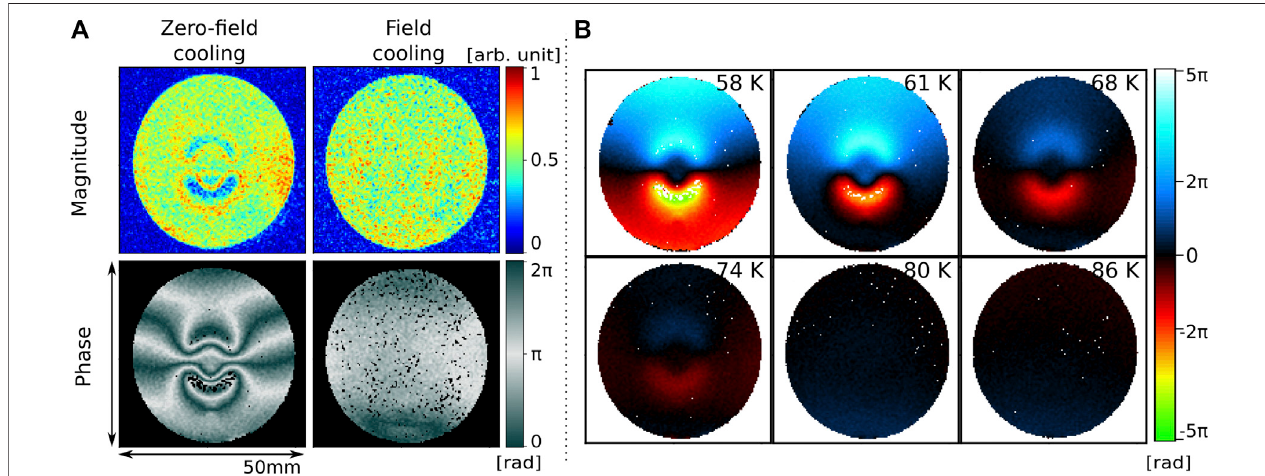
→ 0 is oriented towards the verticalaxis of the images. In (B) , the phase